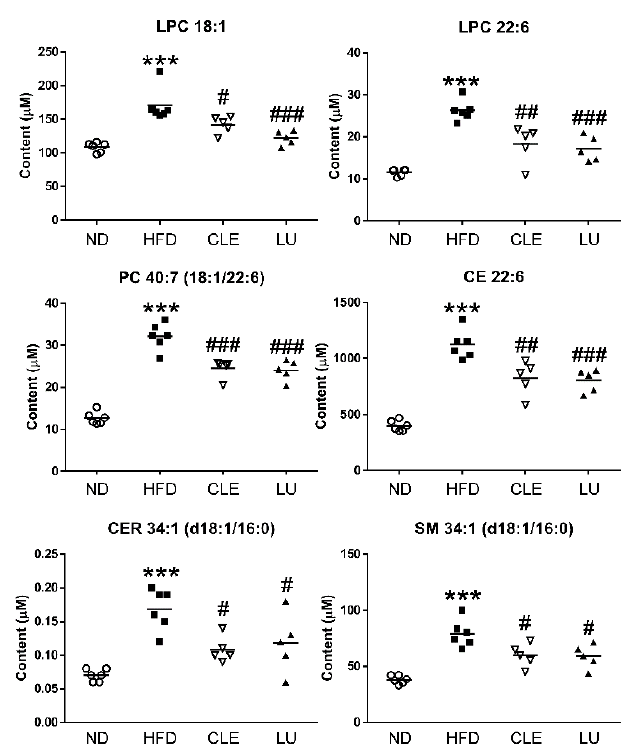
Figure 6. Scatter plot showing significant differences in the levels of the lipid biomarkers with the same lipid compositions among the normal diet (ND), high-fat diet (HFD), HFD plus Chrysanthemum morifolium Ramat leaf extract 1.5% diet (HFD + CLE), and HFD plus luteolin 0.003% diet (HFD + LU) groups. Each symbol represents an individual mouse (Circle ( ○ ): ND; Box ( ■ ): HFD; Inverted triangle ( ▽ ): CLE; Triangle ( ▲ ): LU; Diamond ( ◆ ): Quality control (QC)). *, # different letters indicate significant difference compared with the normal diet (ND) group (*) and the HFD group (#), as determined by Tukey’s multiple comparisons test. (*** p < 0.001, # p < 0.05, ## p < 0.01, ### p < 0.001). LPC: lysophosphatidylcholine; PC: phosphatidylcholine; CE: cholesteryl ester; CER: ceramide; SM: